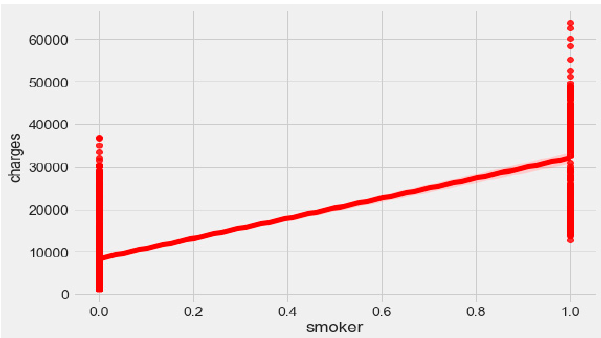
Figure 7. Relationship between “smoker” and “charges”.